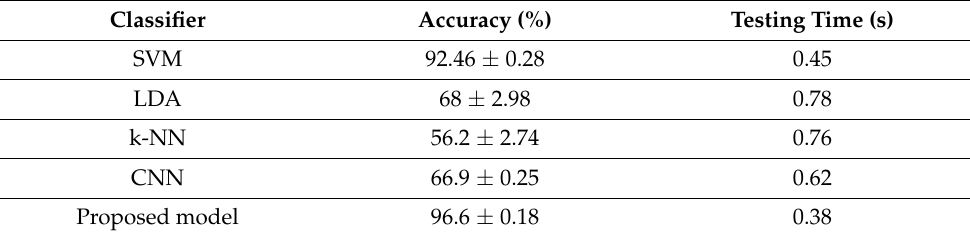
Table 4. Comparison of the proposed model with different classification models.